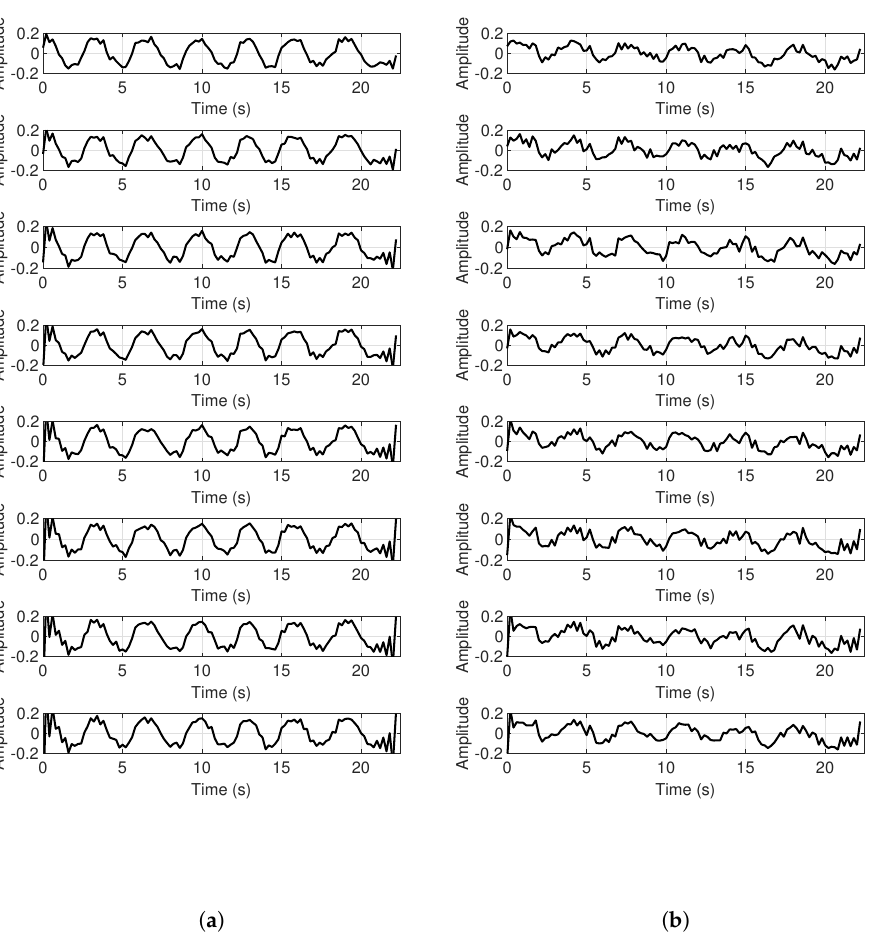
Figure 5. Collected radar data after the pre-processing step: ( a ) for one person, ( b ) for multiple persons.